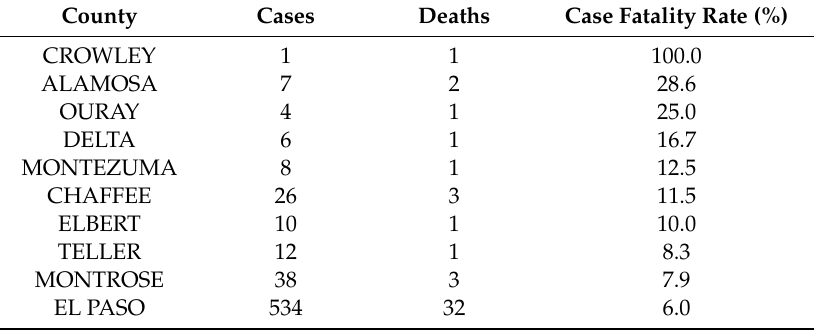
Table A1. Top ten counties by case fatality rates (%) in